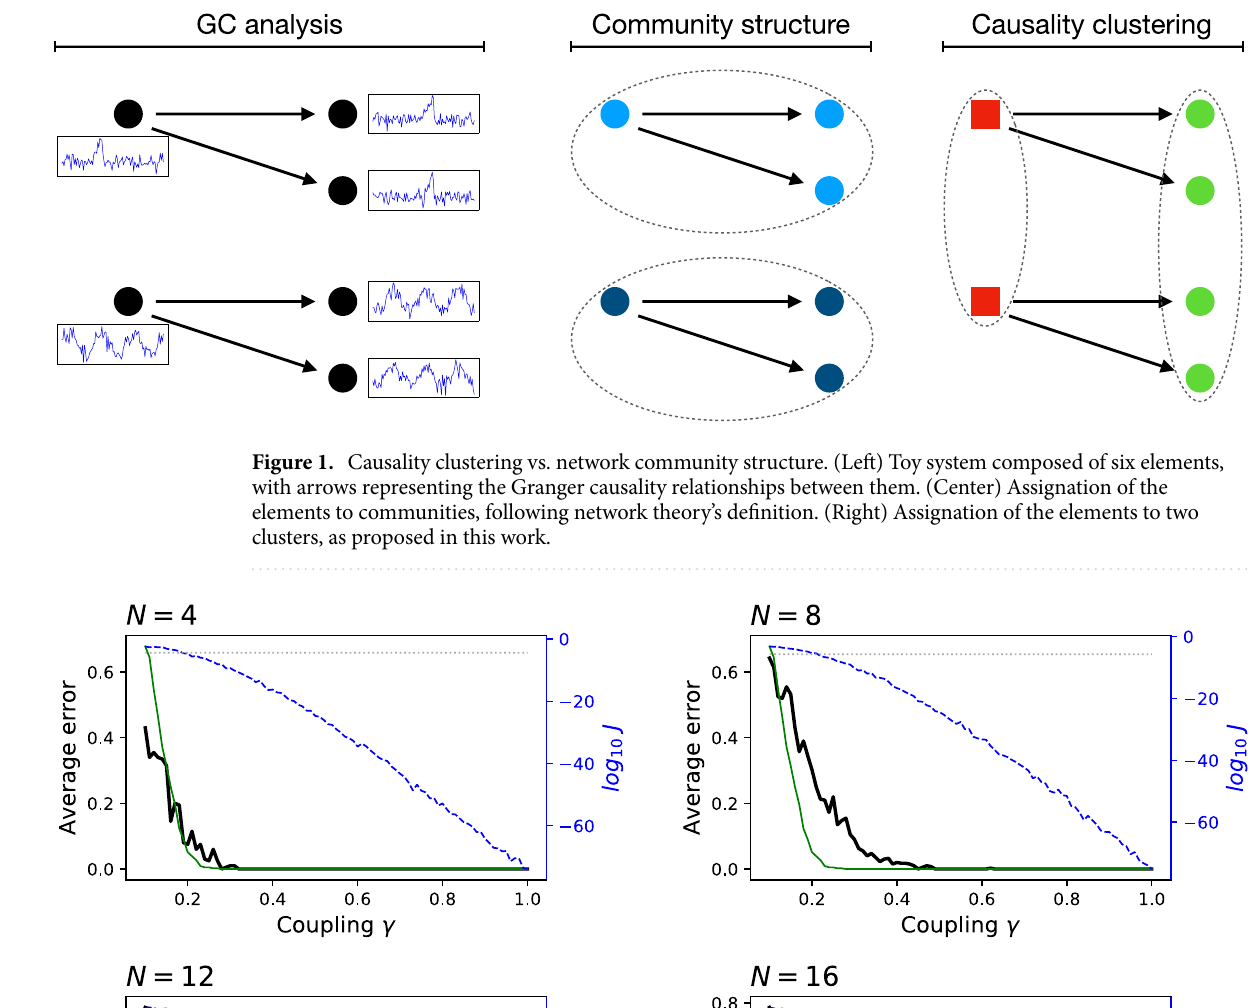
The four panels of Fig. 2 present the results for N = 4 , 8, 12 and 16. Specifically, the black lines correspond to the average error (fraction of misassigned elements) as a function of the coupling γ ; and the blue dashed lines the log 10 of the average J (right axis). As a reference, the thin green lines further depict the fraction of Granger causality tests failing to detect a statistically significant result (with α = 0.01 ) between x 1 and x N / 2 + 1 , i.e. on a single pair of time series, also as a function of γ ; and the dotted horizontal grey line the average J obtained for uncorrelated time series (right axis). It can be appreciated that the exact solution is always recovered; yet, this comes at the cost of a larger value of the coupling γ when the system includes a large number of elements. The